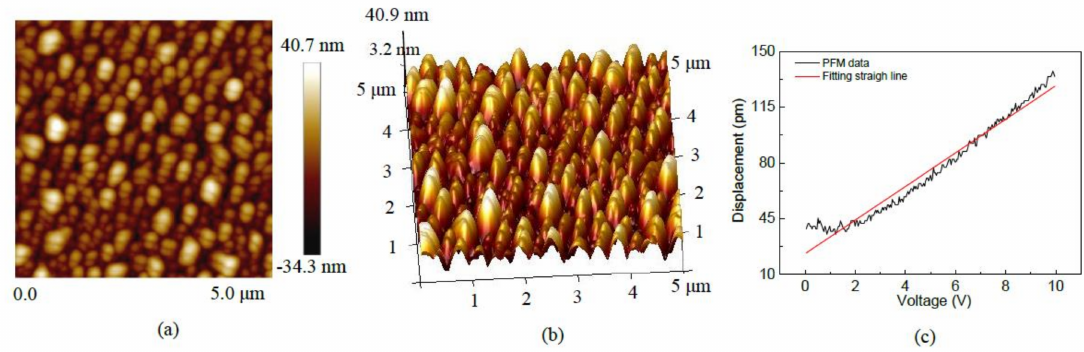
Figure 8. Piezoresponse force microscopy (PFM) images of 5 wt% Li-doped ZnO thin films: ( a ) the two-dimensional topography; ( b ) the three-dimensional topography; ( c ) the relationship curve between stylus tip displacement and excitation